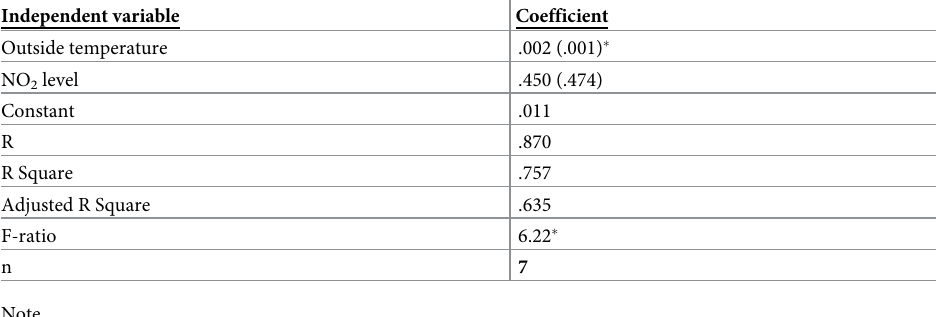
Table 3. Effect of NO 2 level and outside temperature on O 3